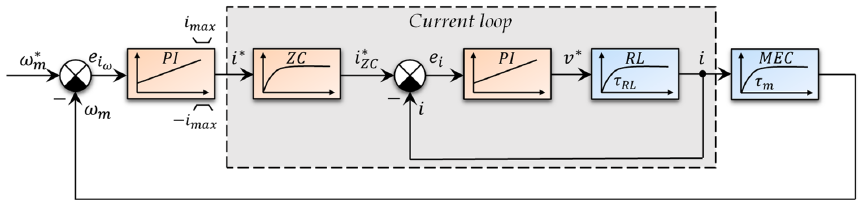
Figure 7. Block diagram of the speed loop.